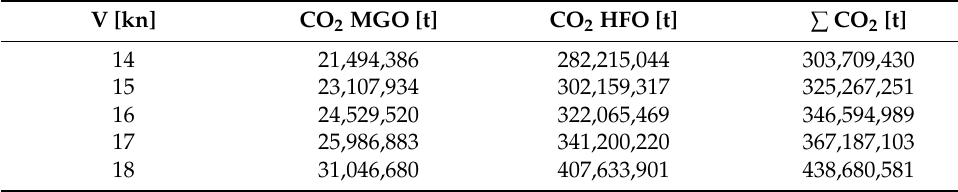
Table 12. Estimated amount of CO 2 emissions generated by container shipping in 2018.